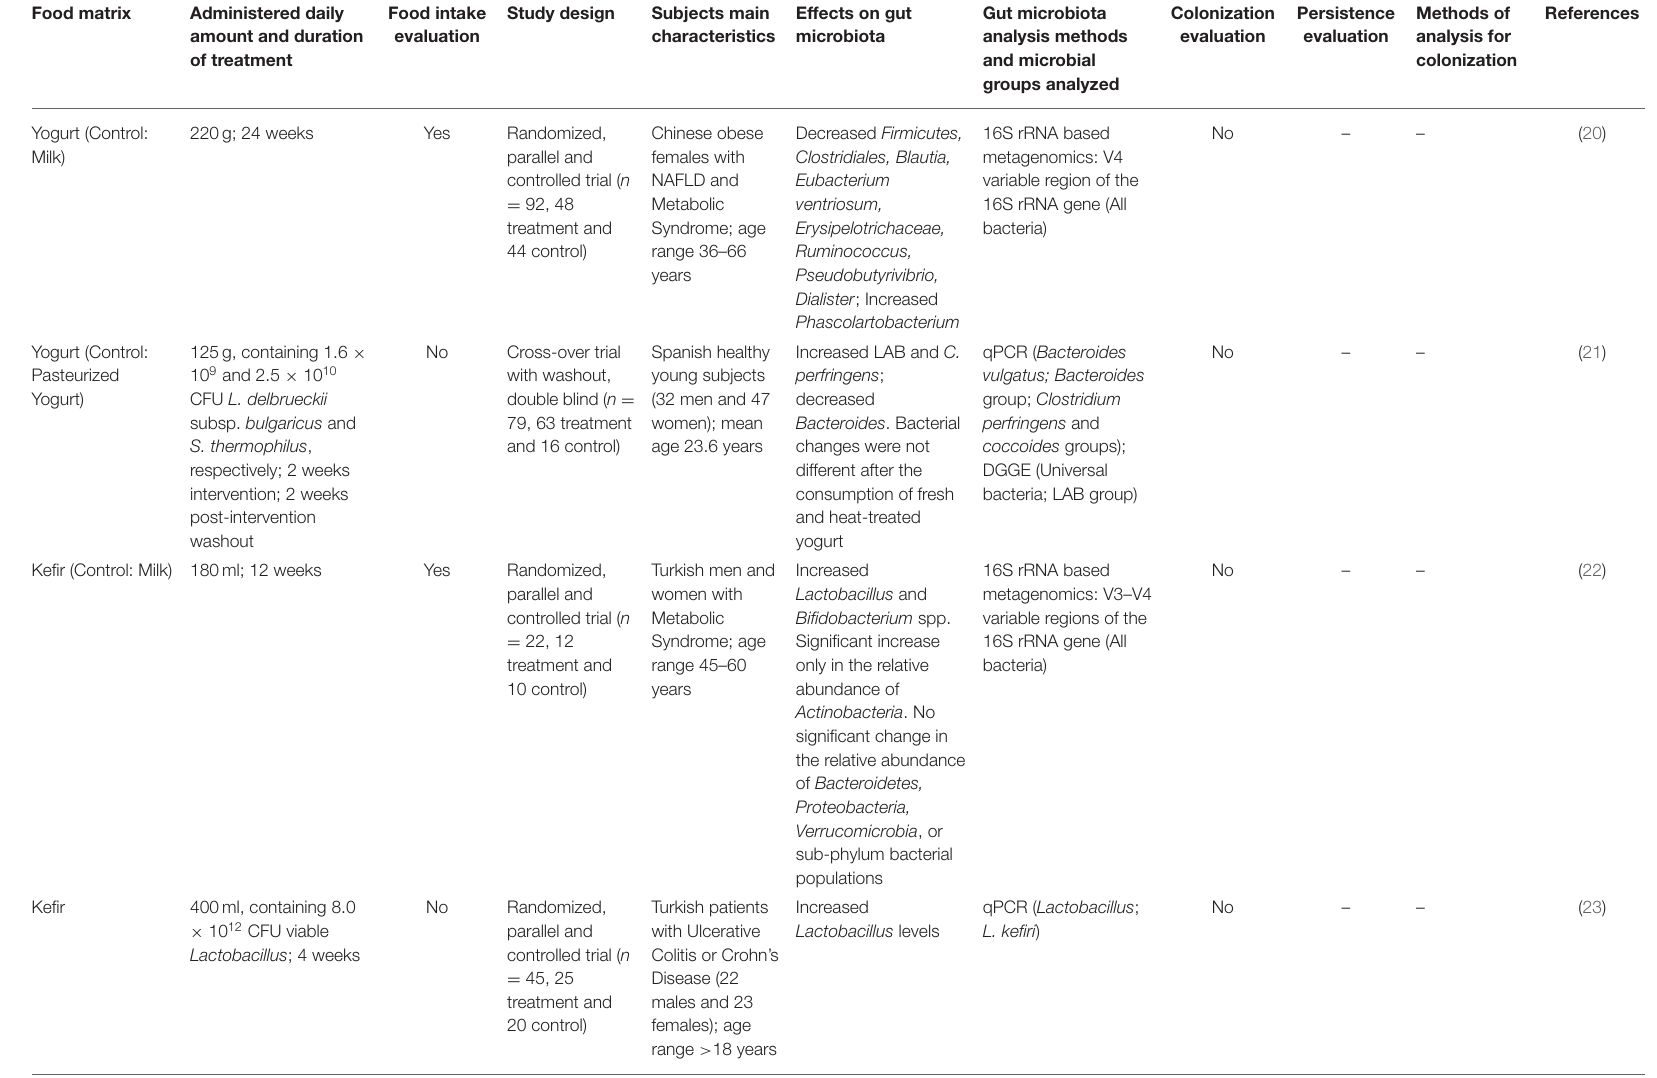
TABLE 2 | Human intervention studies using traditional or commercial fermented